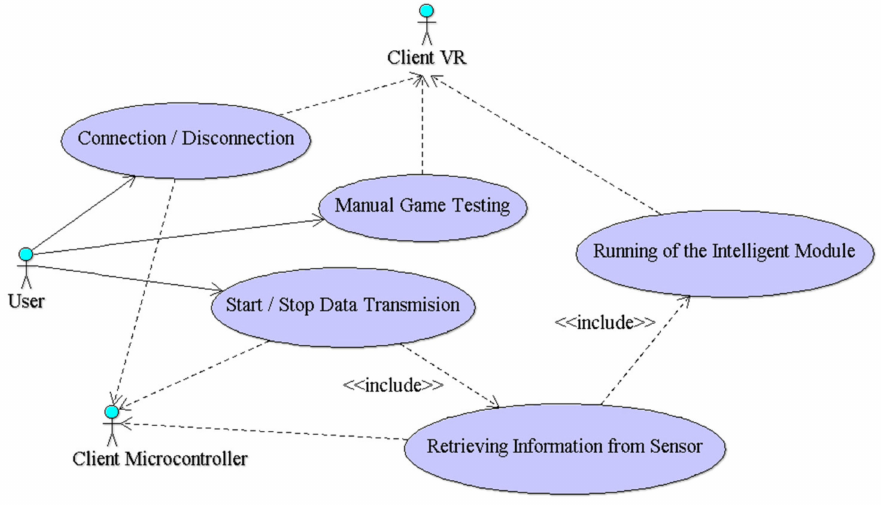
Figure 5. Use case diagram corresponding to the server